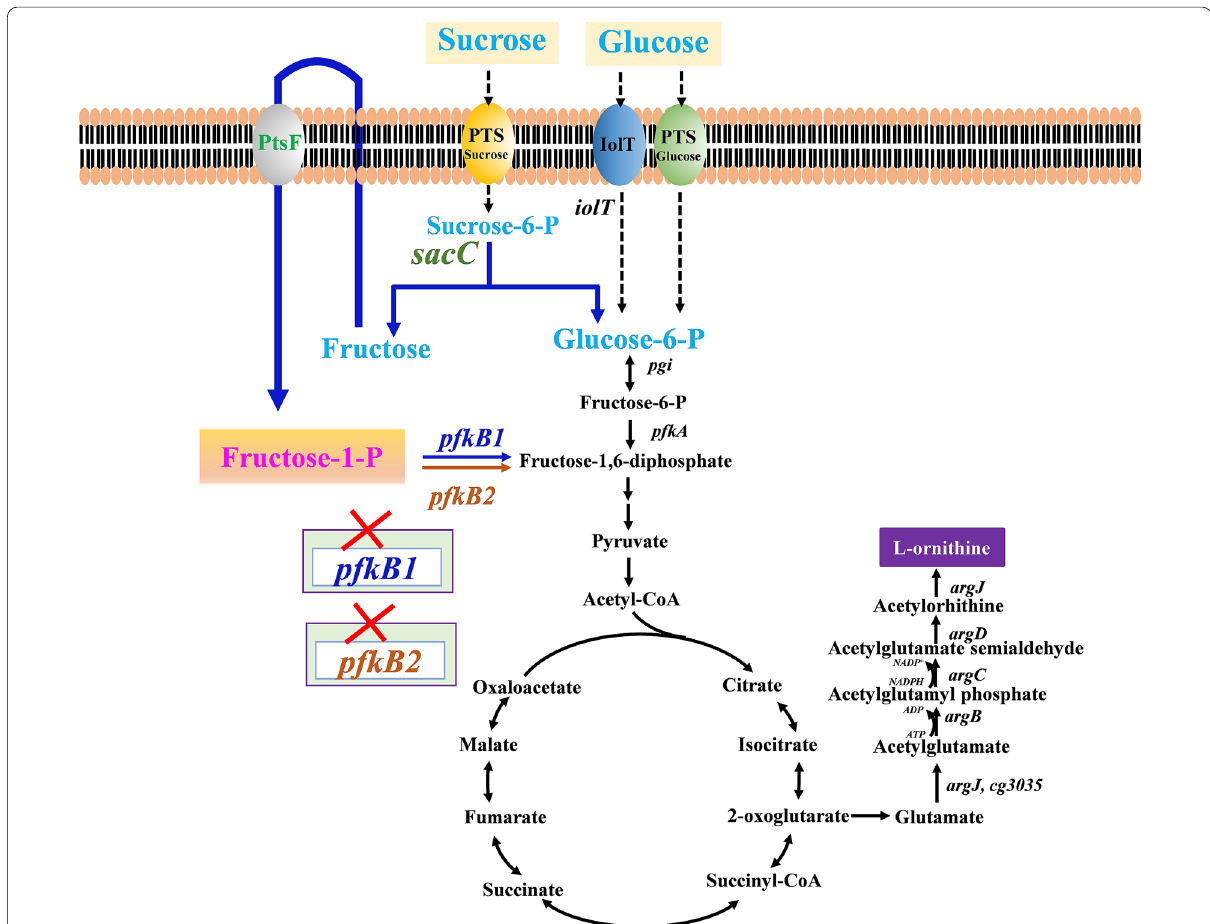
Fig. 1 The metabolic pathways and schematic diagram of genetic engineering modulations in C. glutamicum for ʟ -ornithine production from glucose and sucrose. The red indicates those genes were inactivated. pfkB1 encodes fructose-1-phosphate kinase-1; pfkB2 encodes × fructose-1-phosphate kinase-2; ptsF encodes fructose transporter; sacC encodes sucrose-6-phosphate